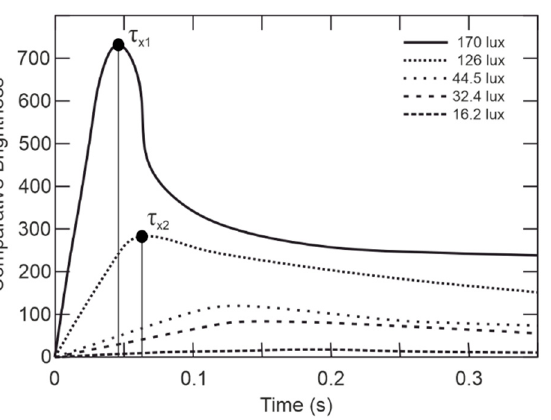
Figure 6. Apparent brightness of flashes with various luminances, as a function of flash duration (adapted from [3]).